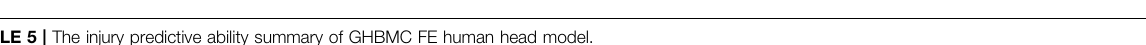
TABLE 5 | The injury predictive ability summary of GHBMC FE human head